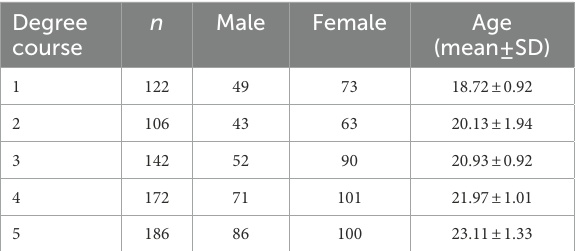
TABLE 1 Frequency distributions by sex and age according to grade